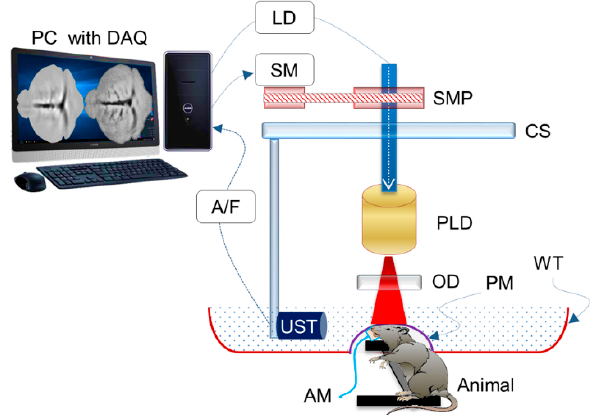
Figure 16. Schematic of the PLD-PAT system for in vivo small animal brain imaging: PLD, pulsed laser diode; OD, optical diffuser; CS, circular scanning plate; SMP, stepper motor pulley unit; UST, ultrasound transducer; A/F, amplifier/filter unit; LD, laser driver unit; SM, stepper motor; PC, personal computer; WT, water tank; DAQ, data acquisition card; AM, anesthesia machine; PM,